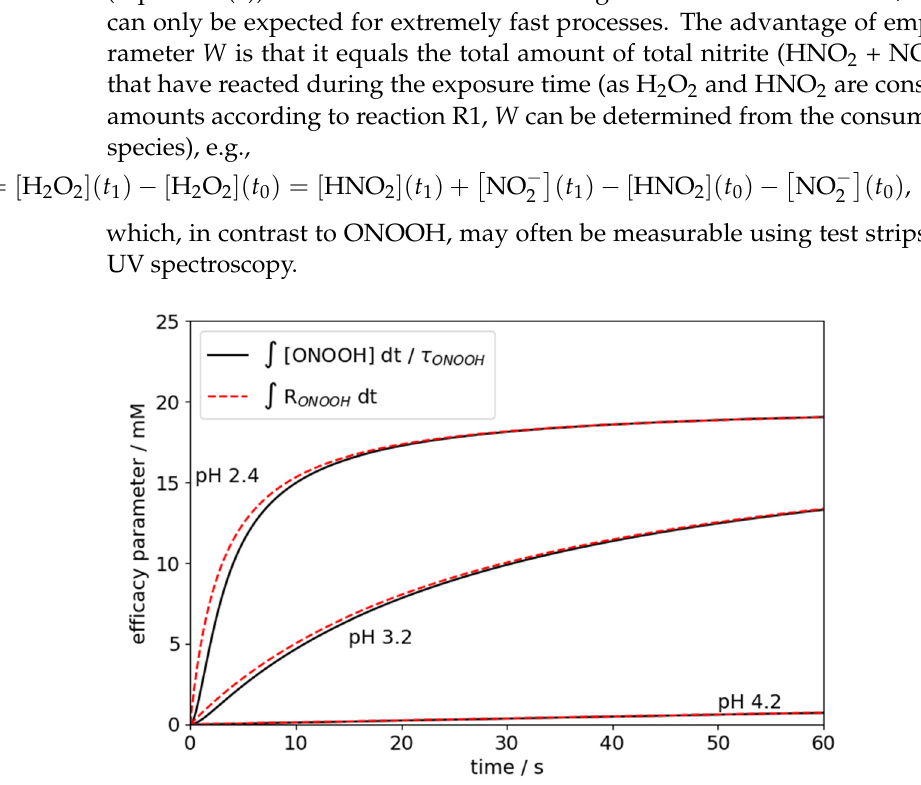
Figure 2. Exemplary comparison of the indefinite integrals according to Haber’s efficacy parameter (see Equation (1)) and the efficacy parameter (cid:1849) (Equation (2)).